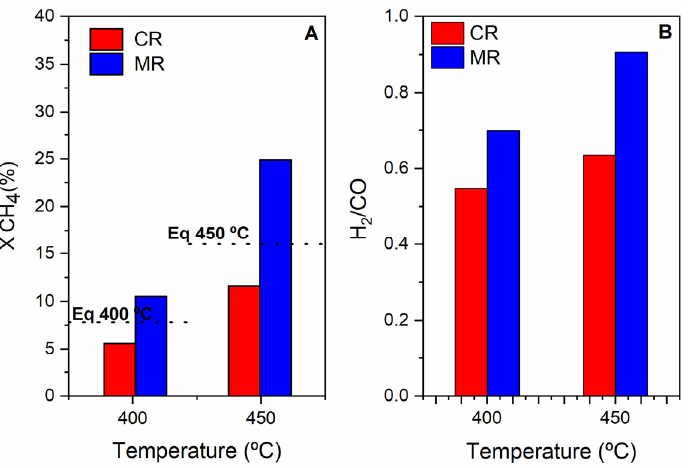
Figure 12. Methane conversion ( A ) and H 2 /CO ratio ( B ) for the DRM reaction in the MR and CR over Ru/ZrO 2 -La 2 O 3 catalyst at 400 and 450 °C.; Feed composition: CH 4 :CO 2 :He = 10:10:80; Total flow rate = 100 mL/min: P = 1 bar. Sweep Gas: 300 mL/min (MR). The dotted line represents the thermodynamic CH 4 conversion value at a given temperature.